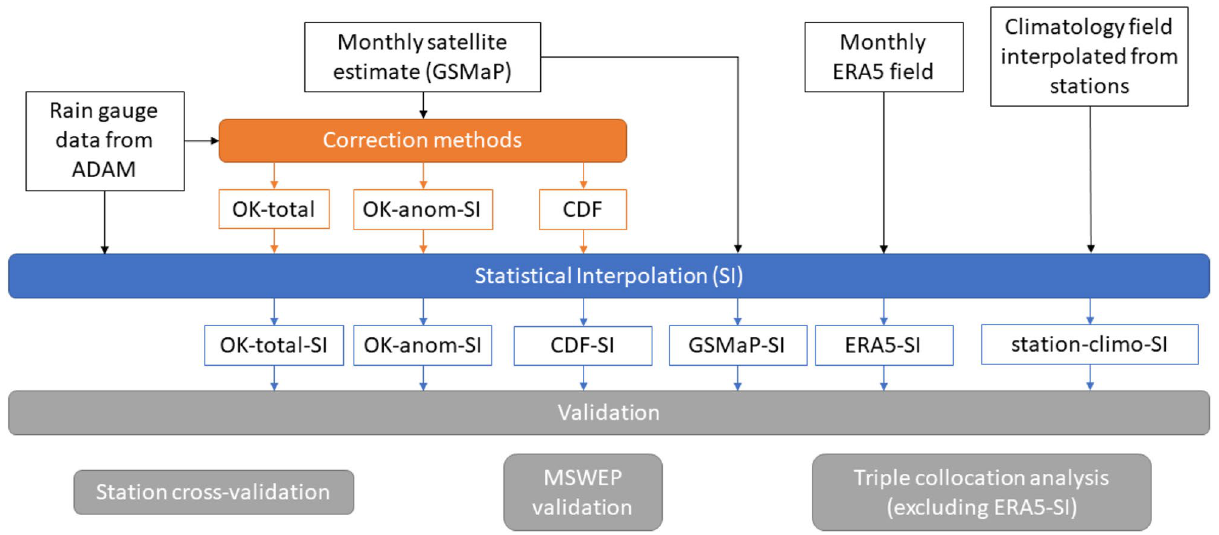
Figure 11. Schematic of the workflow. Input datasets are shown in the black boxes, corrected satellite datasets are shown in orange boxes, datasets produced by statistical interpolation (SI) are shown in blue